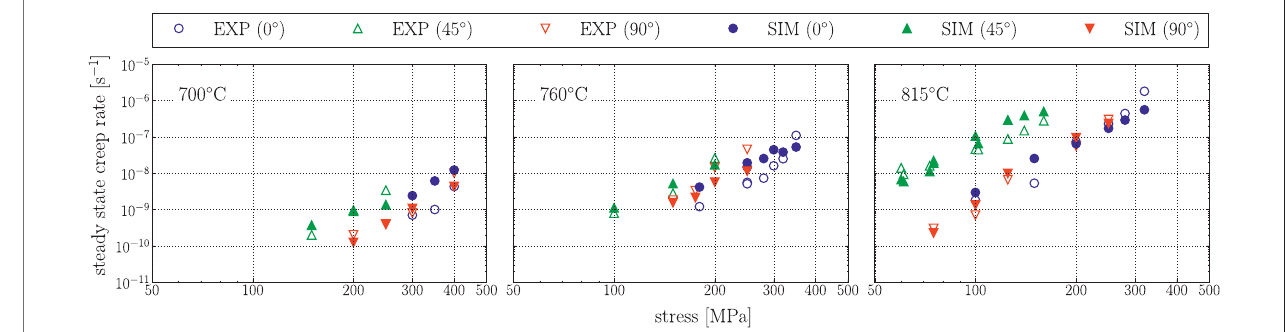
FIGURE 7 | Steady-state creep against stress. Comparison of simulations to experiments from Parthasarathy et al. (2000).